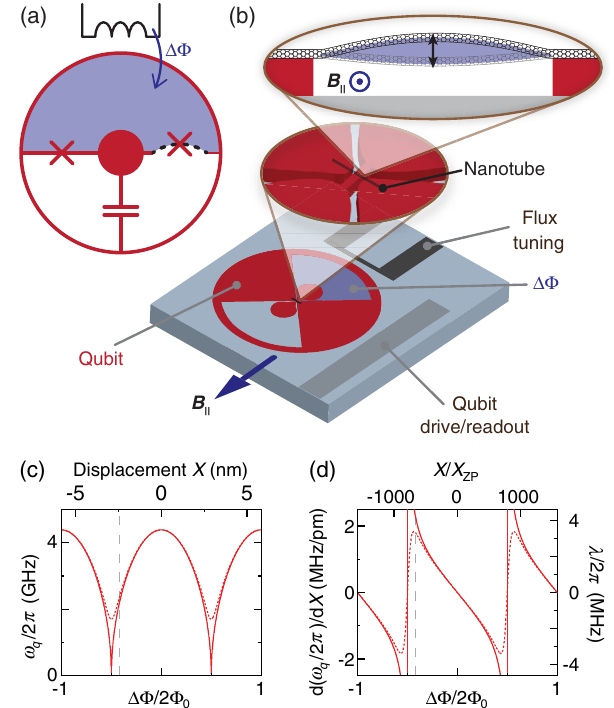
FIG. 1. Device for strong qubit-mechanical coupling. (a) Elec- trical schematic. The device is a gradiometric transmon qubit, biased by flux difference ΔΦ between the SQUID loops. With a suspended nanotube acting as at least one junction (shown here for the right junction), the displacement modifies ΔΦ and therefore modulates the qubit energy levels. (b) Arrangement of the qubit, vibrating nanotube, flux tuning coil, and drive/readout cavity antenna. The in-plane magnetic field B introduces strong coupling jj between the vibrations and ΔΦ . (c) Qubit frequency as a function of flux difference, with parameters as in the text. Solid lines assume equal Josephson coupling in the two SQUID junctions; the dotted line assumes 30% asymmetry (see Appendix A). Curves are plotted as a function of flux (bottom axis) and, equivalently, of displacement (top axis). (d) Qubit displacement sensitivity (left axis) and mechanical coupling rate (right axis) as a function of flux. The bias point that achieves the assumed coupling is indicated by a vertical dashed